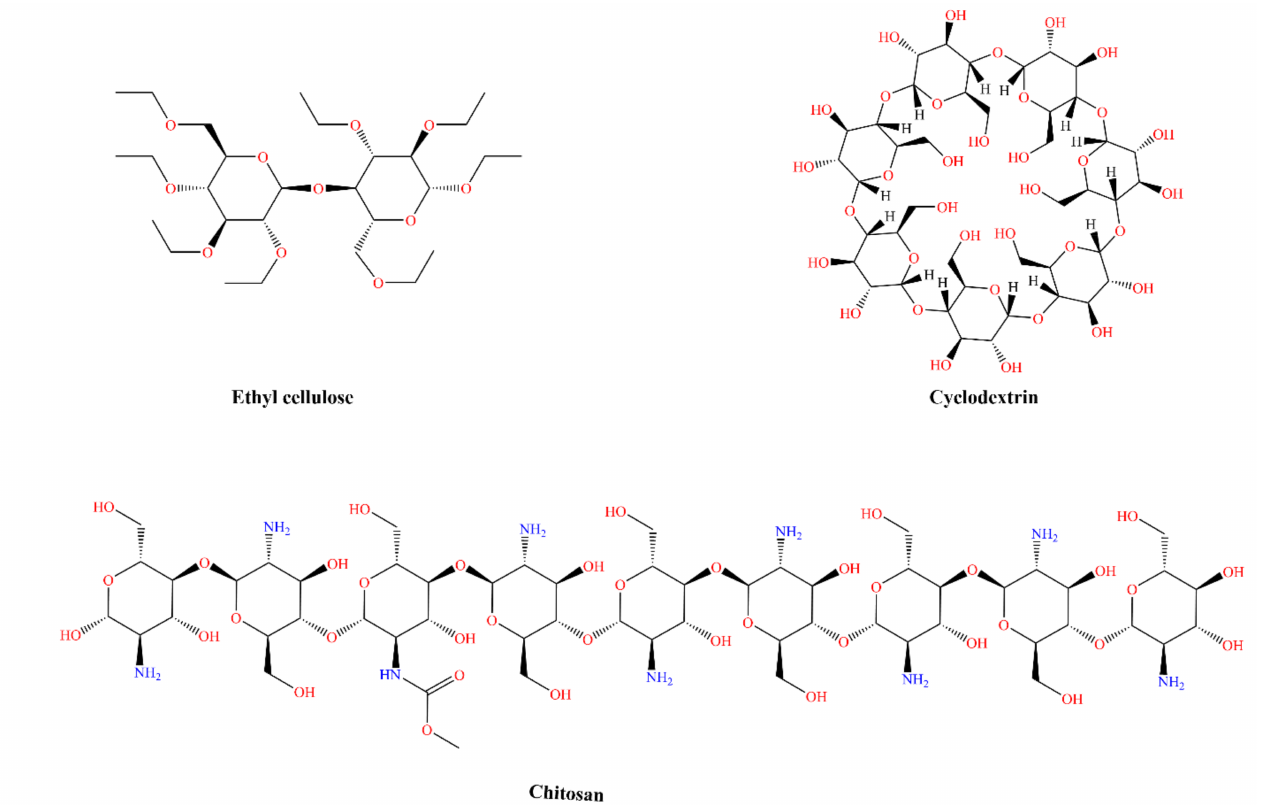
Figure 1. Chemical structures (drawn using CambridgeSoft ™ , Cambridge, MA, USA) of some examples of excipients used in powder formulations of protein and